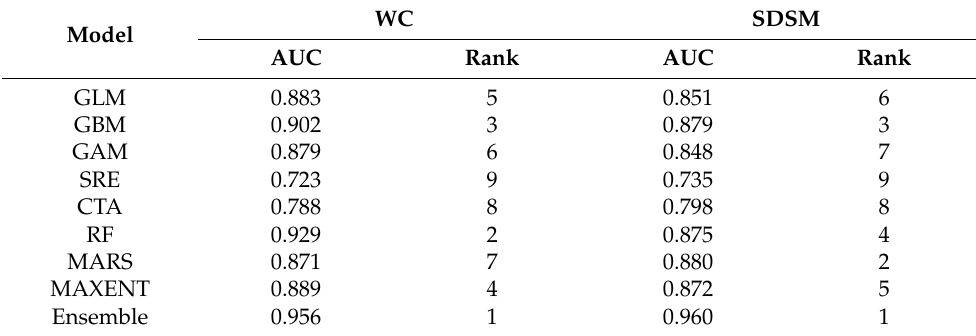
Table 2. Testing AUC values of ENM models based on WC and SDSM datasets.